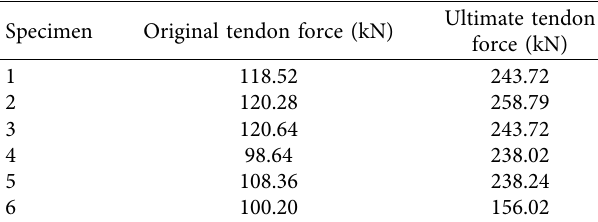
Table 2: Original and ultimate tendon